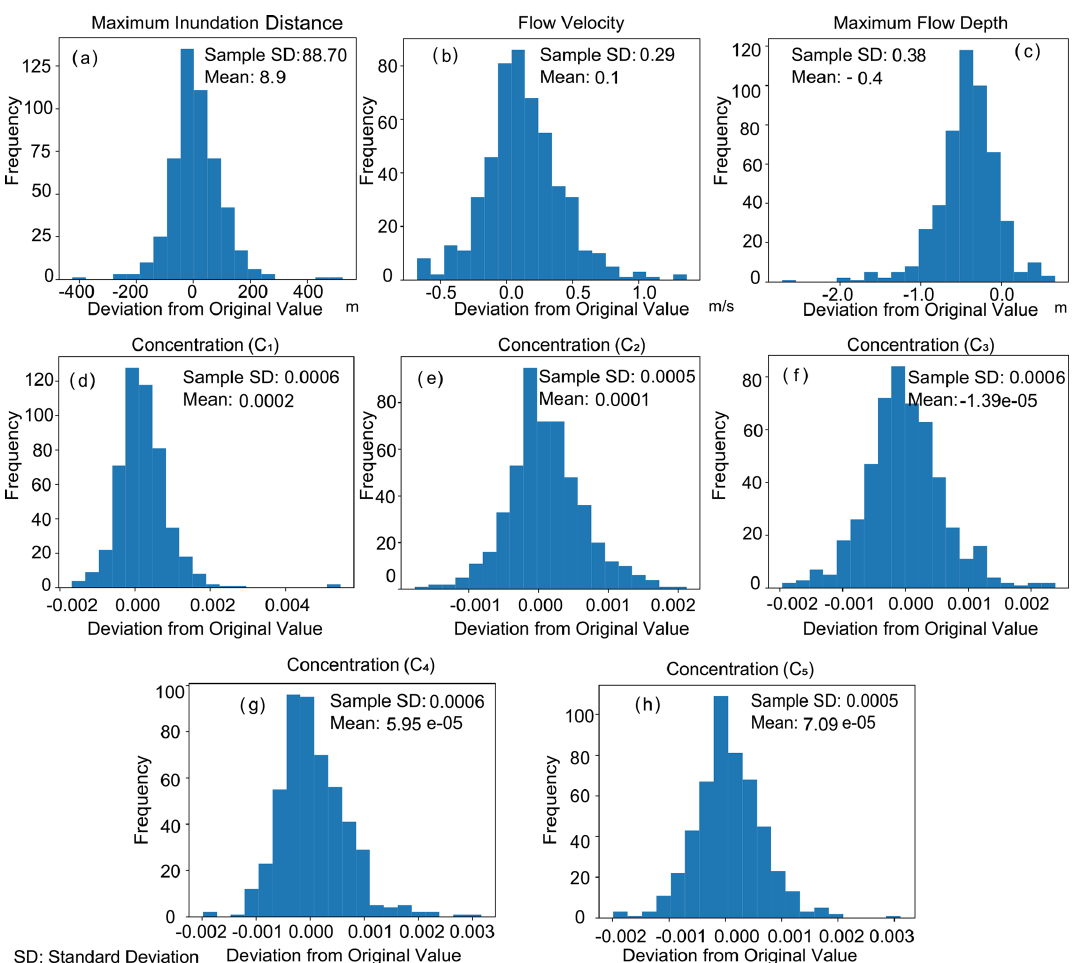
Figure 8. Histograms showing the deviation of the predicted results from the original values of the artificial test data